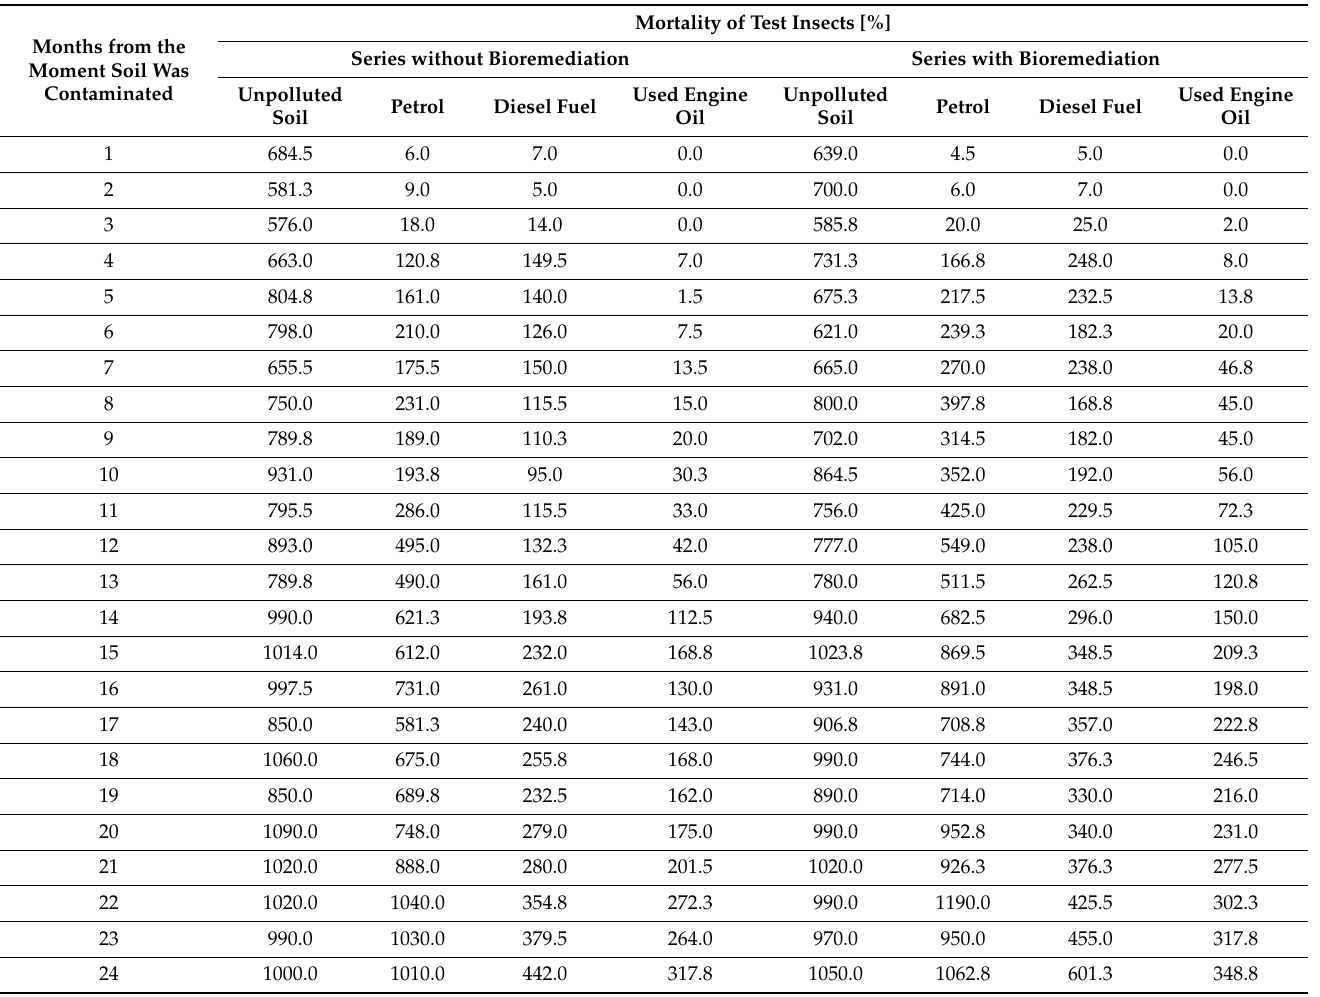
Table 3. The virulence coefficient of S. feltiae